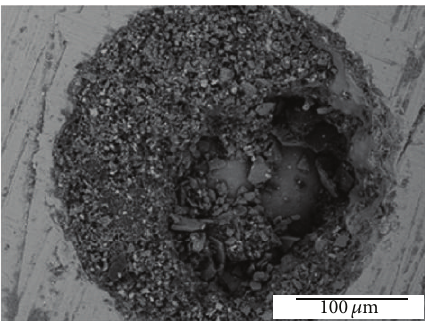
Figure 19: SEM image of particles inside a dimple on the die radius of texture #5 after hot stamping